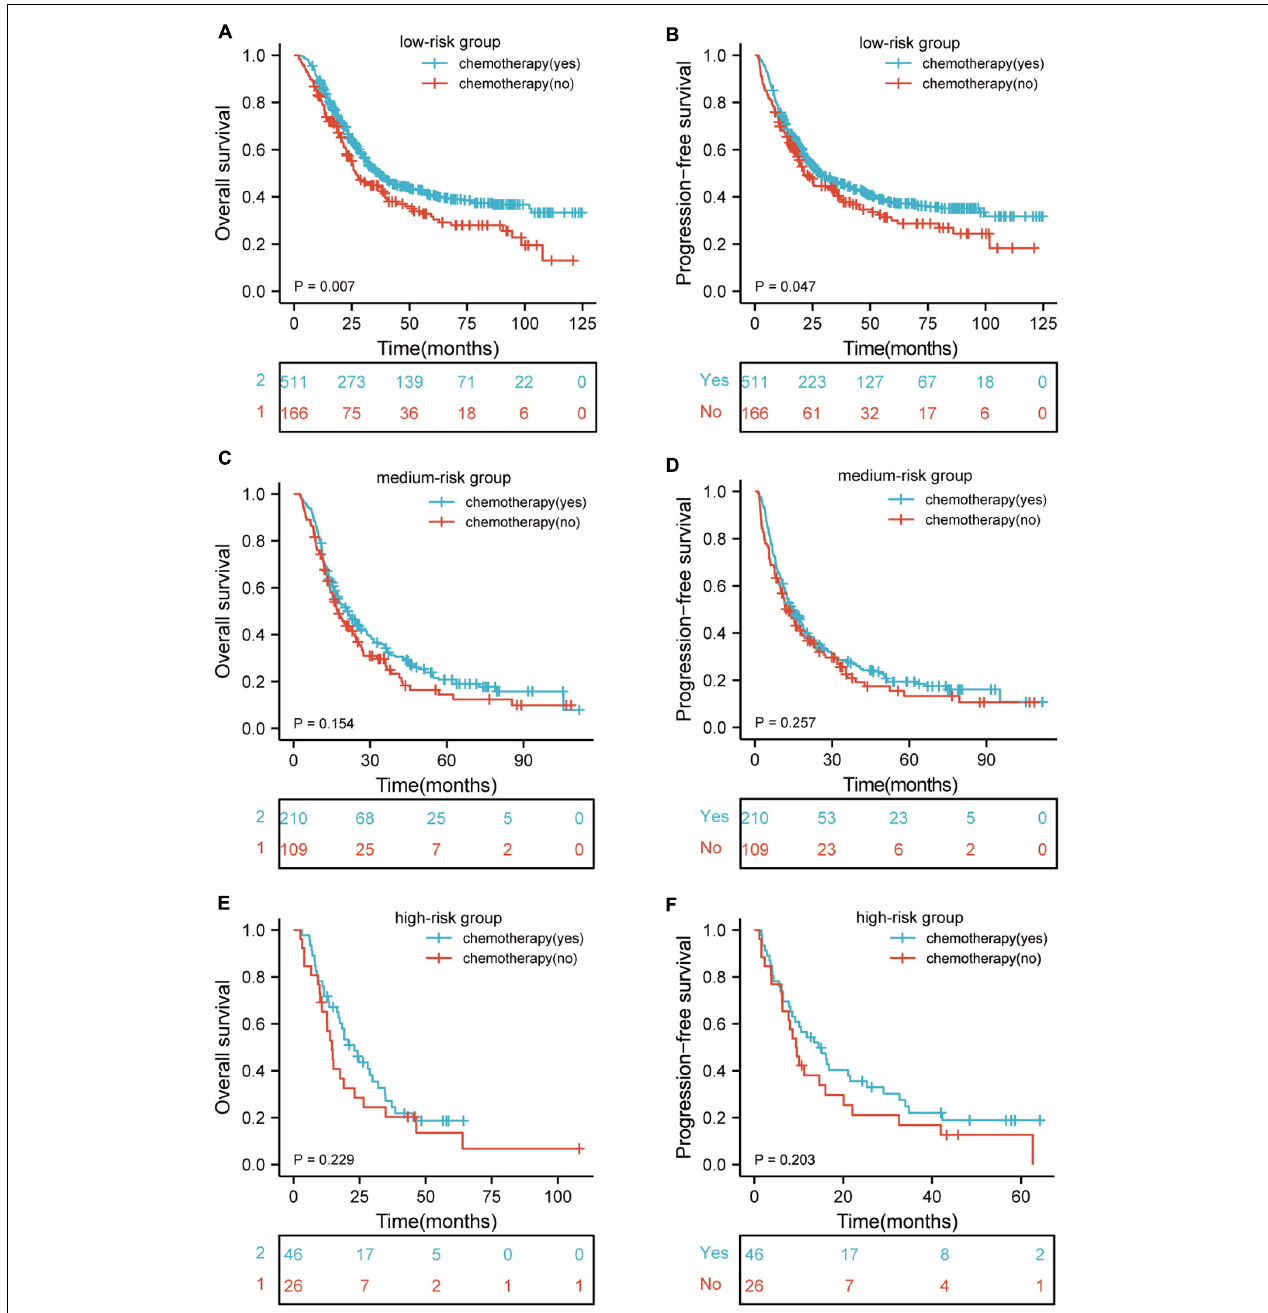
FIGURE 5 | Kaplan–Meier curves according to patients who receive and did not receive chemotherapy showing (A,B) overall survival ( p = 0.007) and progression-free survival ( p = 0.047) for patients receive and did not receive chemotherapy in low-risk group; (C,D) overall survival ( p = 0.154) and progression-free survival ( p = 0.257) for patients receive and did not receive chemotherapy in medium-risk group; (E,F) overall survival ( p = 0.229) and progression-free survival ( p = 0.203) for patients receive and did not receive chemotherapy in high-risk group. HR, hazard